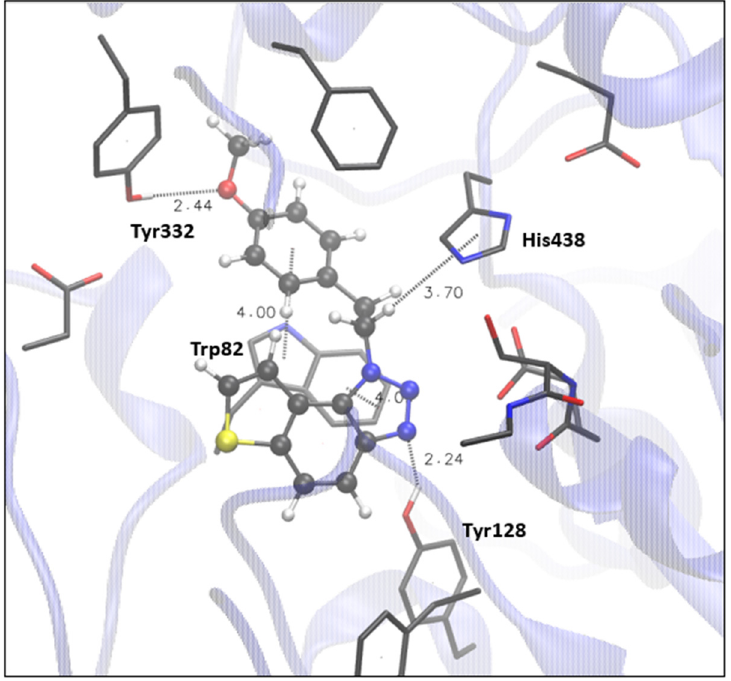
Figure 6. The structure of the complex between compound 9 (presented with a ball-and-stick model) and the active site of BChE. Hydrogens of the enzyme residues omitted for